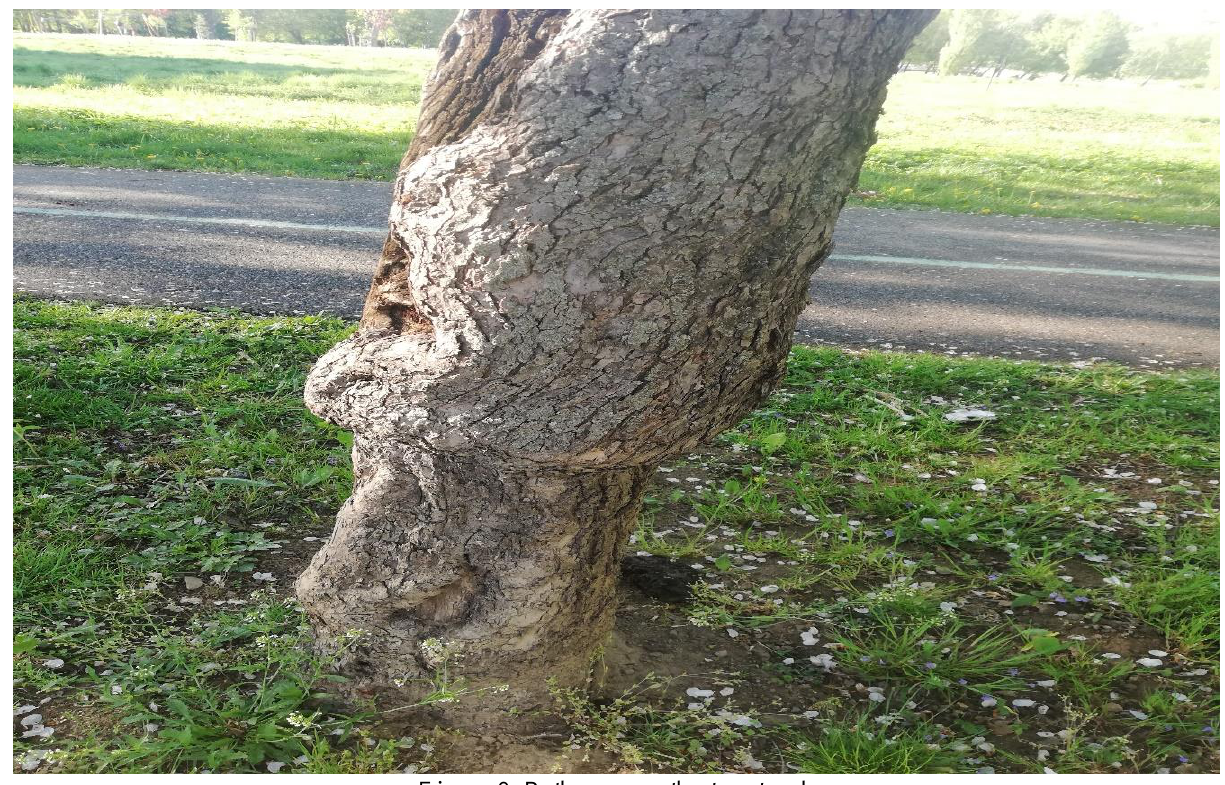
Figure 9. Pathogen on the tree